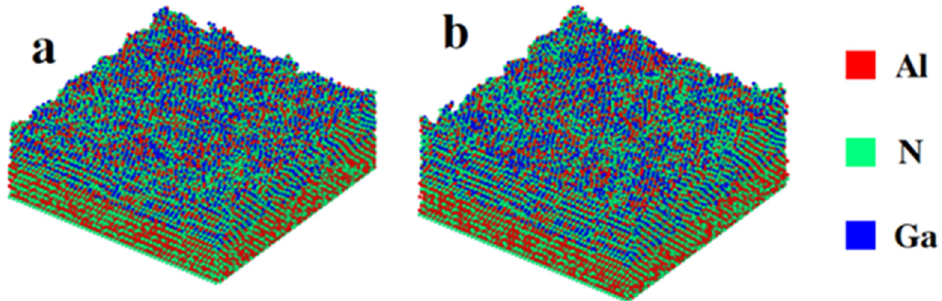
Figure 1. Atomistic structure of deposited AlGaN films at 1350 K. ( a ) sample A, ( b ) sample B. The atoms are colored in red, green, and blue for Al, N, and Ga atoms, respectively. Sample A has 127,224 atoms for constant temperature annealing. Sample B contains 154,844 atoms for laser thermal annealing.